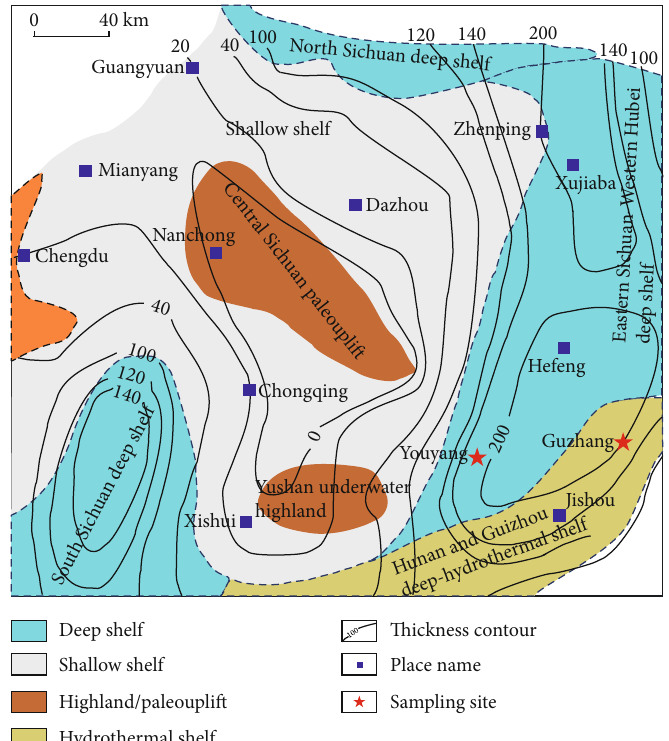
Figure 1: The thickness of the Lower Cambrian shale on the Middle and Upper Yangtze and the sampling sites (modi fi ed after [26]).